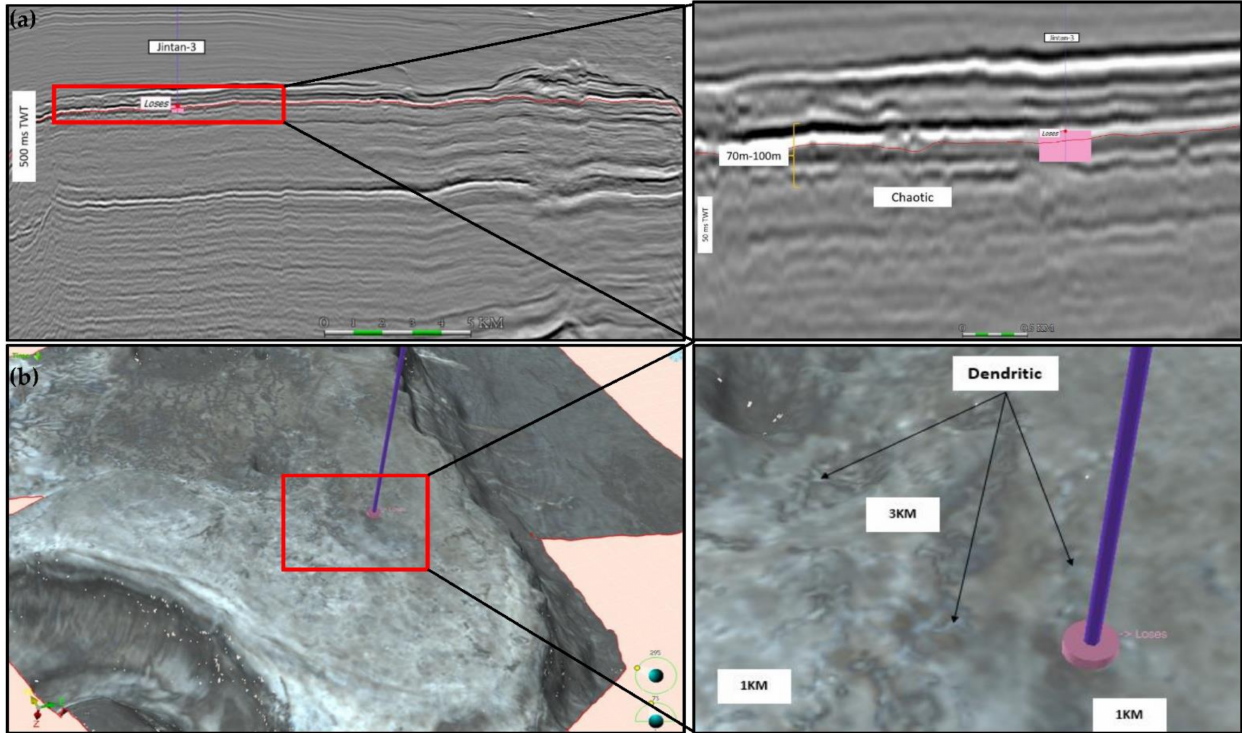
Figure 10. ( a ) The lost circulation depth marked at Jintan-3 well falls on the chaotic seismic facies which revealed the approximate height of the cavern karst geobodies are 70–100 m. Horizon marked in red is the interpreted horizon exactly on the losses depth. ( b ) Time slice of the interpreted horizon show that the loss depth marked in pink falls within the prominent 1–3 km long dendritic